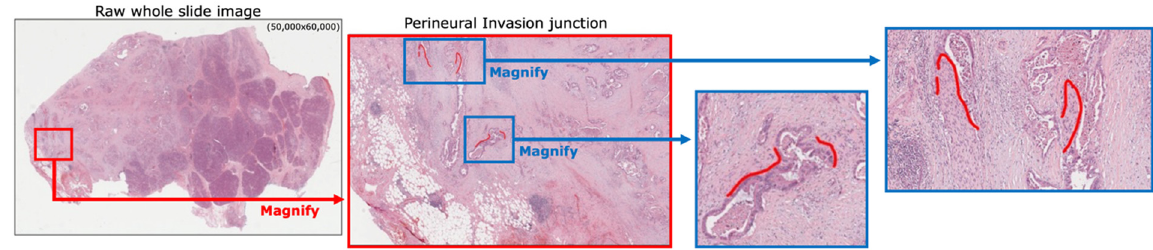
Figure 1. Visualization of PNI (perinueral invasion) junction from raw WSI (whole slide images).